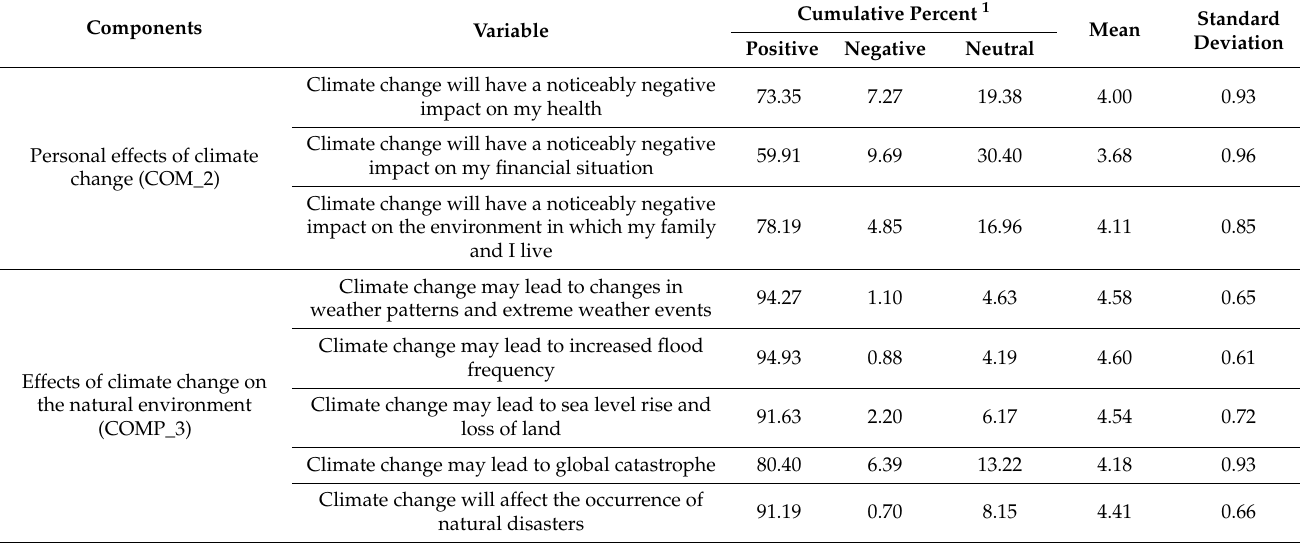
Table 5. Descriptive data on the questions regarding the perceptions of climate change effects on person and the environment.